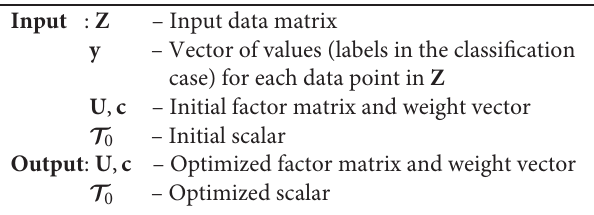
Algorithm 1: GN algorithm using dogleg trust-region for the type II